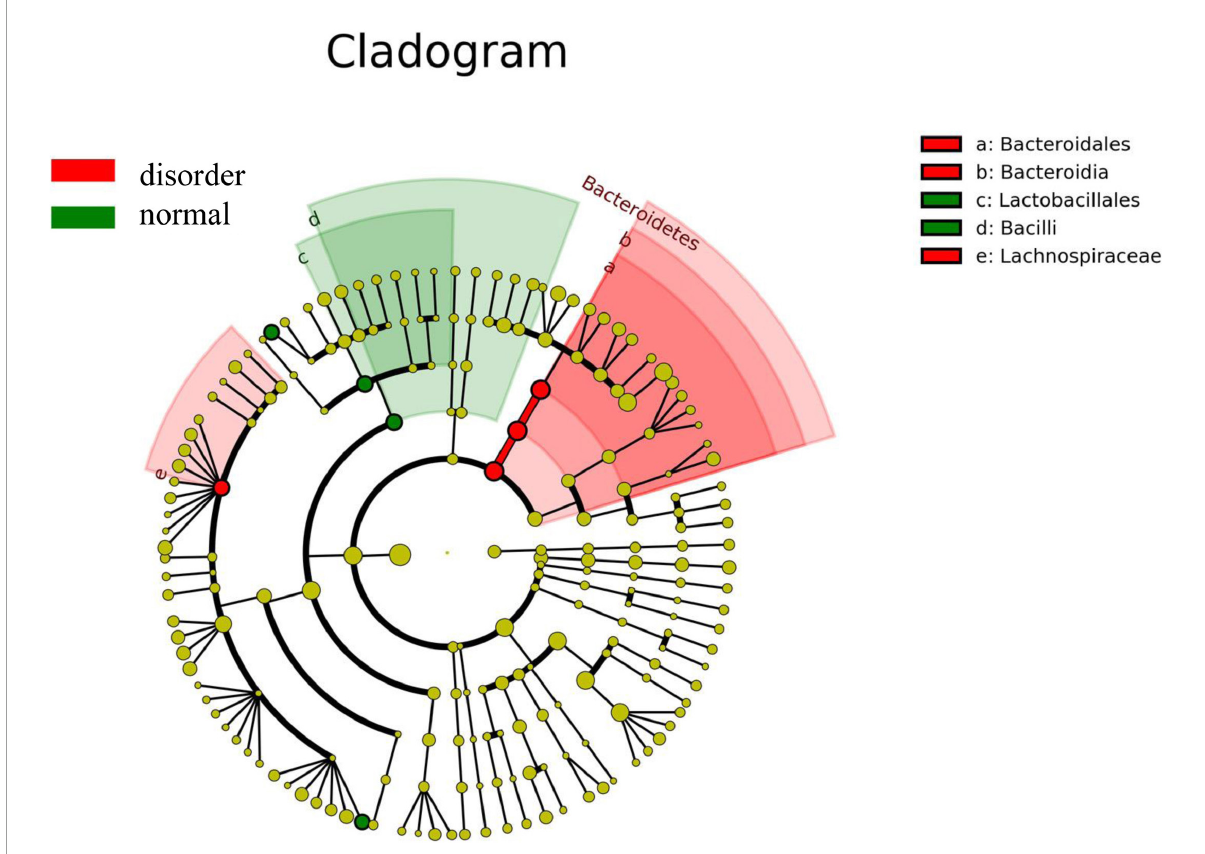
FIGURE4 Group grouping comparison and analysis of the evolutionary cladistic map. The small circle radiating from inside to outside represents the species classification level of phylum, class, order, family, and genus, respectively, and the diameter of the small circle represents relative abundance. The different color nodes in the evolutionary tree are the microbial groups that play an essential role in this color group. The species name corresponding to the biomarker not shown in the figure is shown on the right, and the letter number corresponds to that in the figure. The intestinal flora of patients with normal sleep after TBI was mainly Bacilli and Lactobacillales, while that of patients with sleep disorders after TBI was mainly Lachnospiraceae and